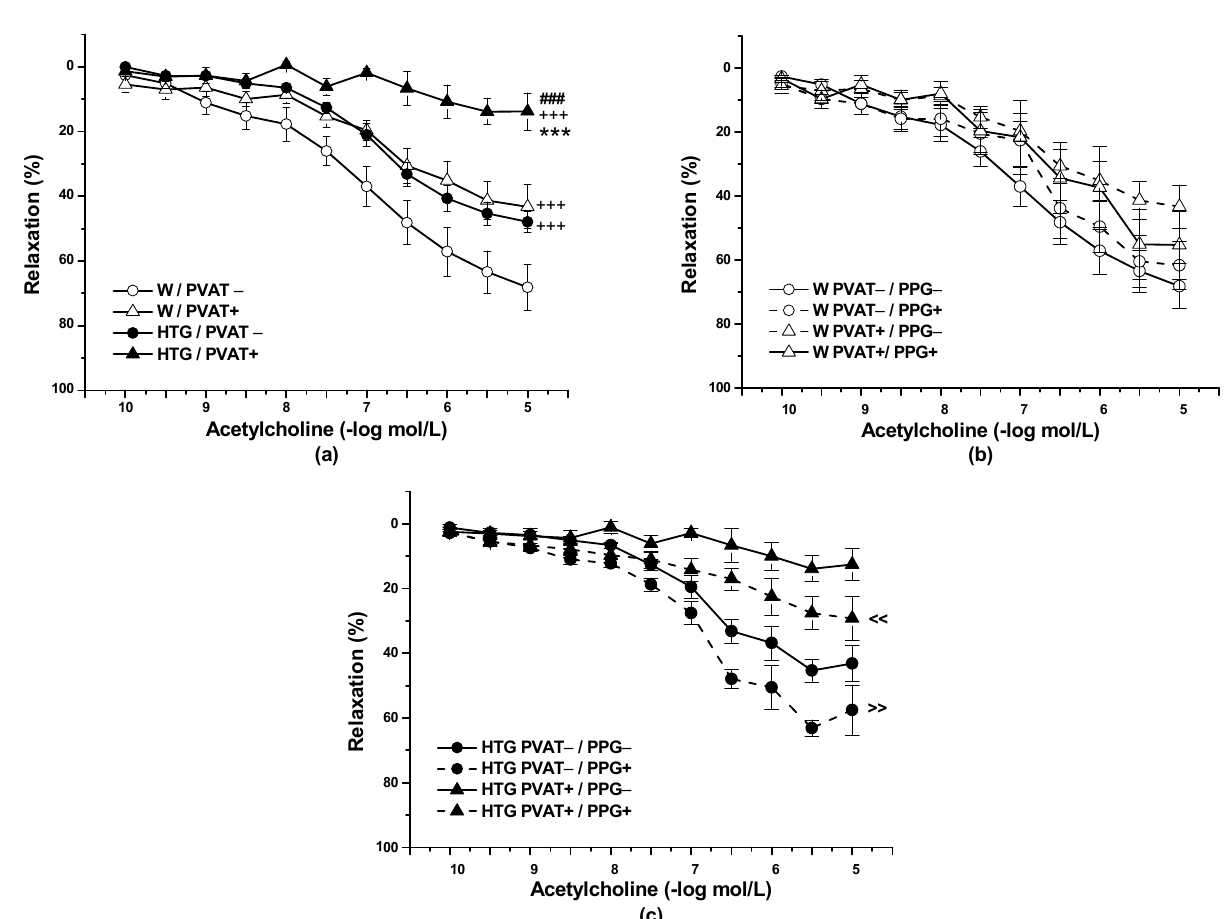
Figure 1. Endothelium-dependent vasorelaxation of the thoracic aorta of normotensive Wistar rats (W, n = 8) and hypertriglyceridemic rats (HTG, n = 9) with intact (PVAT+) or removed (PVAT-) perivascular adipose tissue ( a ) before (PPG-) and after (PPG+) pretreatment with propargylglycine ( b , c ). The results are presented as the mean ± S.E. M, and differences between groups were analyzed by three-way analysis of variance (ANOVA) with the Bonferroni post hoc test on ranks. *** p < 0.001 vs. W/PVAT+; +++ p < 0.001 vs. W/PVAT-; ### p < 0.001 vs. HTG/PVAT-; << p < 0.01 vs. HTG PVAT+/PPG-; >> p < 0.01 vs. HTG PVAT-/PPG-.